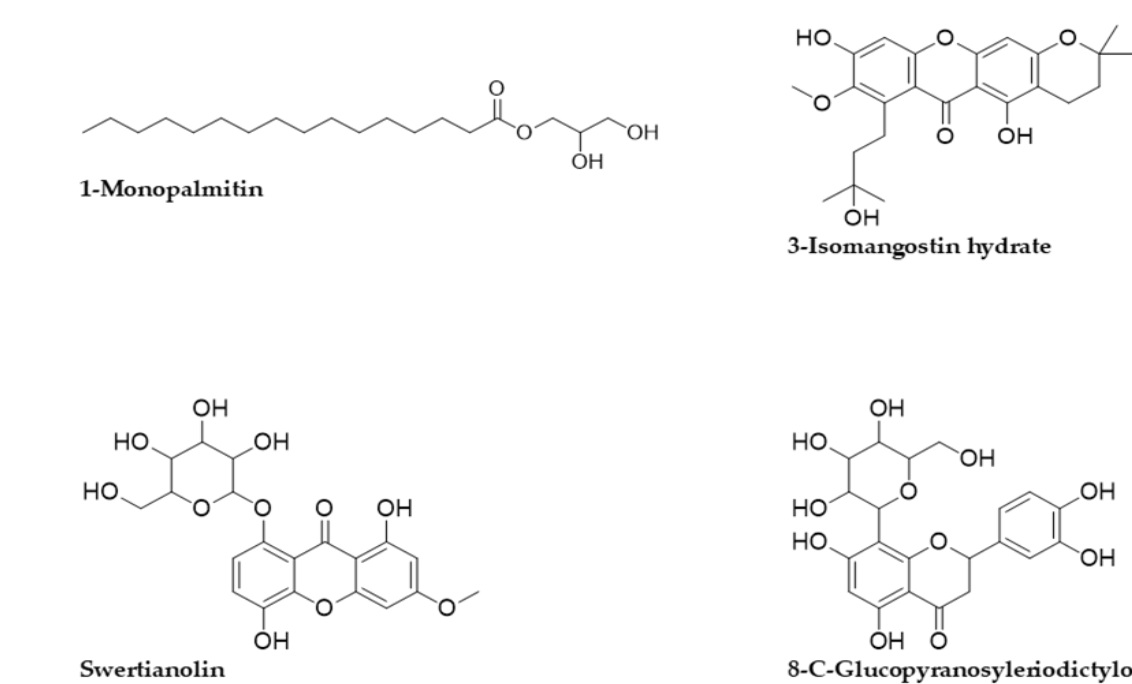
Figure 2. 2D structures of the tentative compounds identified by Q-ToF-LCMS analysis. Table 3. Bioactive compounds identified by Q-ToF-LCMS.